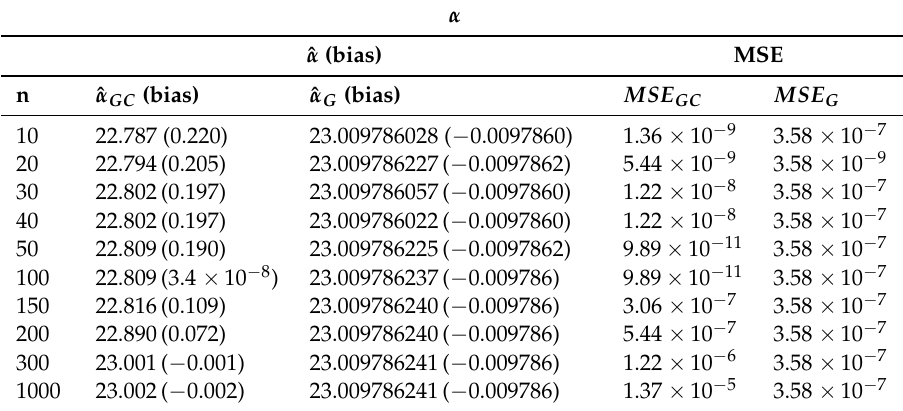
Table 4. MLEs of α with the conjugate gradient method and gradient method.